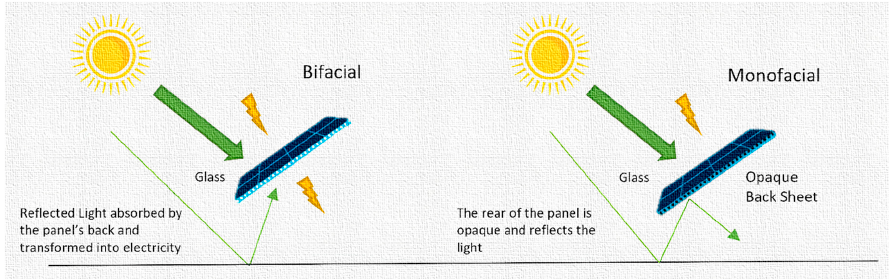
Figure 2. Bifacial vs. mono-facial solar panels.